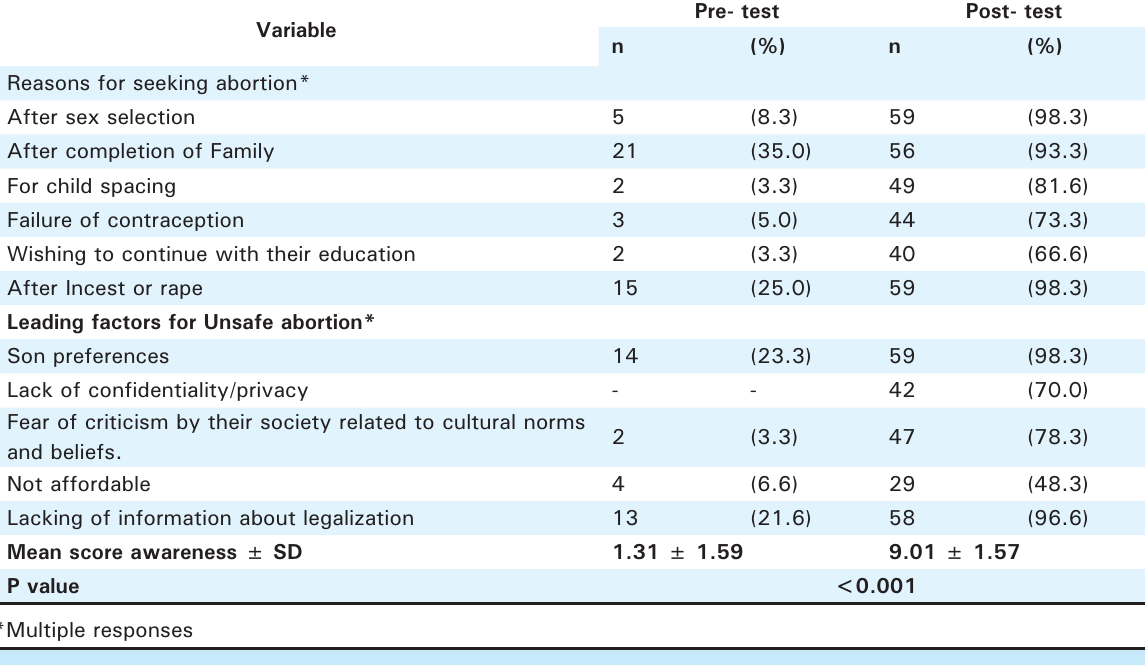
Table 3. Respondents’ Awareness about Reasons for Seeking Abortion and Leading Factors to Unsafe Abortion Before and After Educational Intervention (n=60).